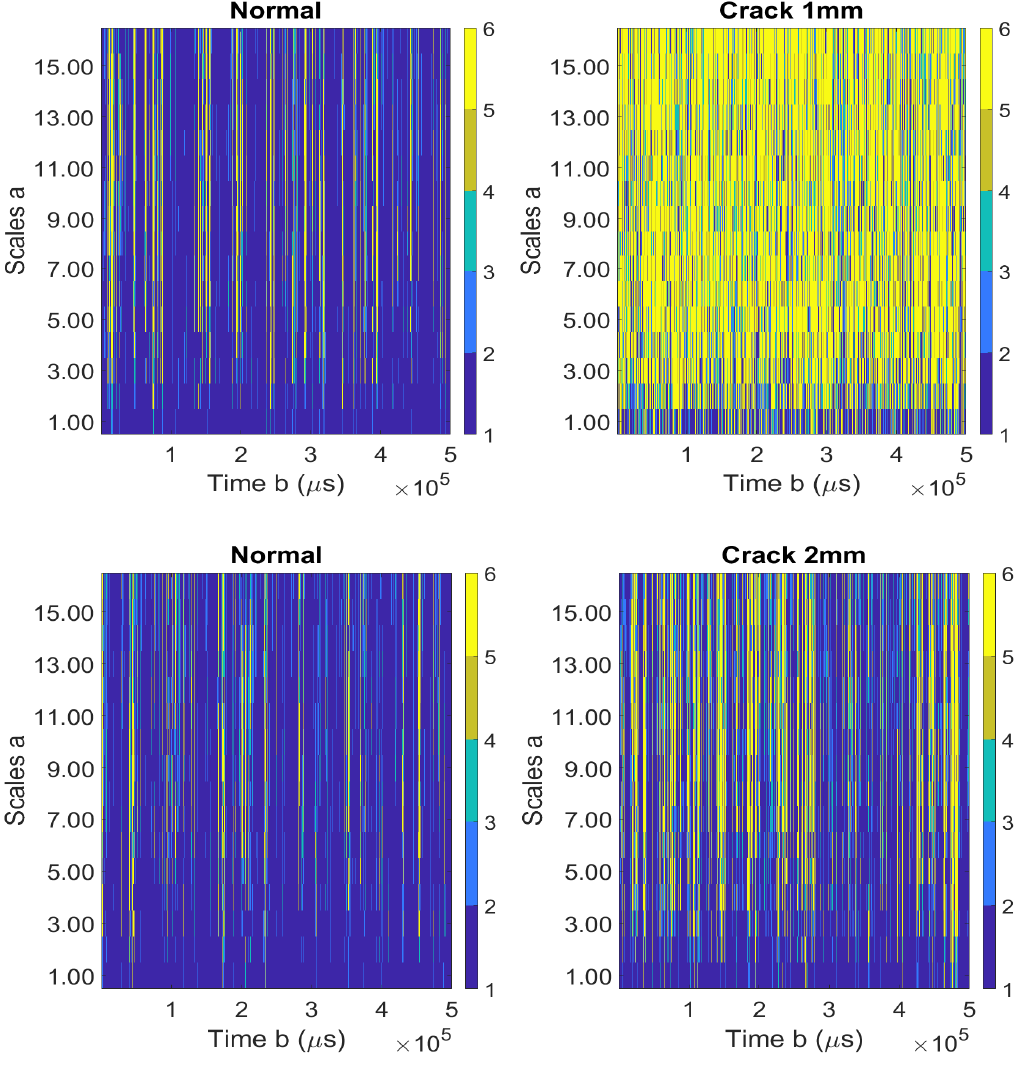
Figure 6. Confusion matrices of classification result for ( a ) the proposed method for impulse detection with ECFAR and ( b ) wavelet threshold-based impulse detection.